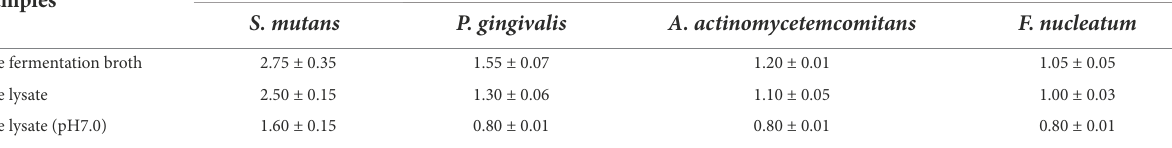
TABLE 1 Inhibition zone on other pathogenic bacteria (cm).